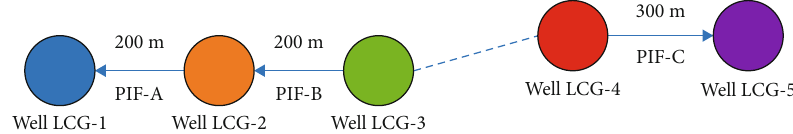
Figure 4: PIF diagram of interwell fracturing